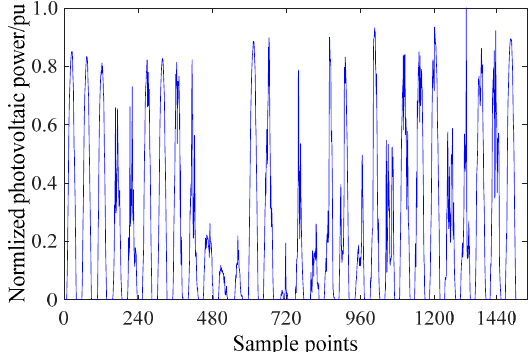
Figure 3. The original PV power series in April 2015.